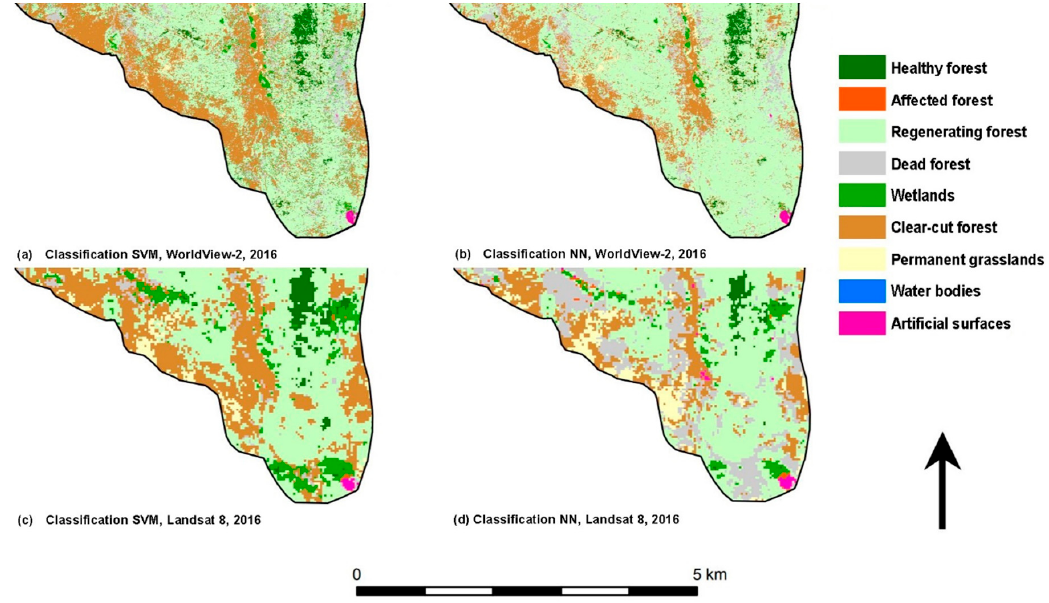
Figure A14. Comparison of the classifications of SVM and NN in the selected locality of the case study.